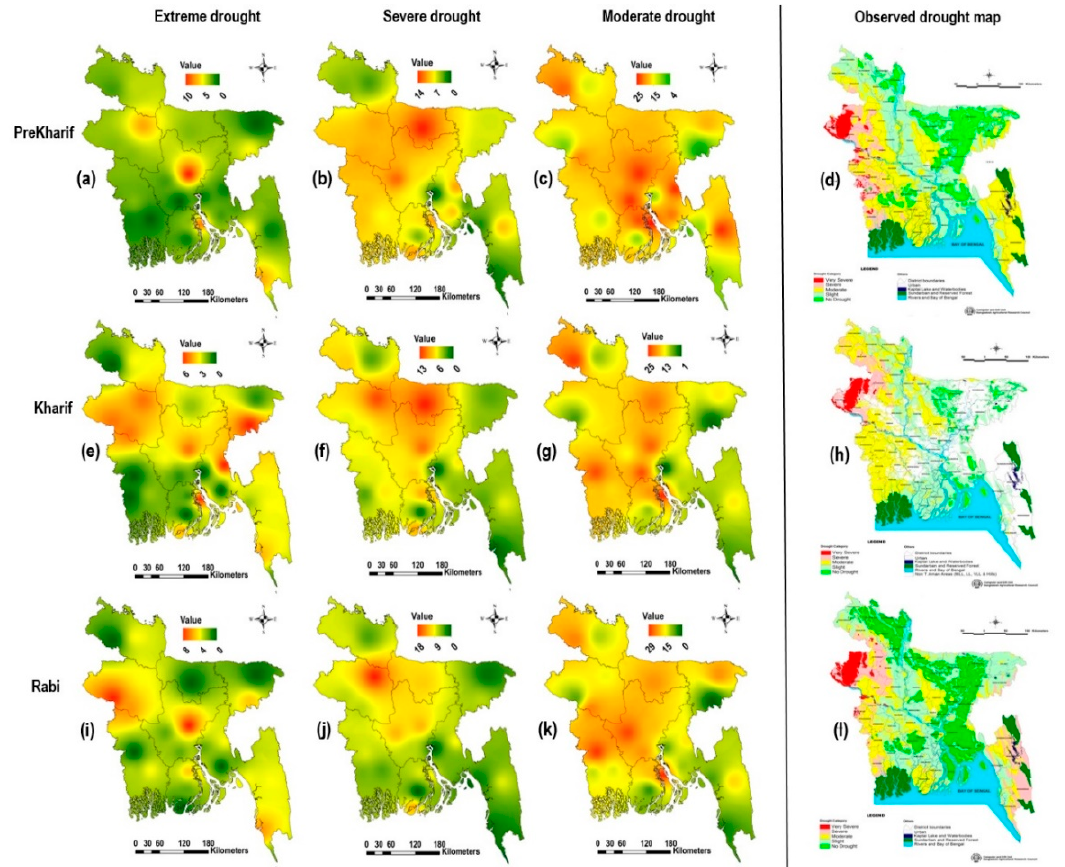
Figure 8. Spatial distribution of seasonal drought in Bangladesh during 1981–2015: Upper row indicates the results for Pre-Kharif season with ( a ) Extreme; ( b ) Severe; ( c ) Moderate Severities, and ( d ) Observed distribution, middle row shows the results for Kharif season with ( e ) Extreme; ( f ) Severe; and ( g ) Moderate Severities and ( h ) Observed distribution and bottom row is for the Rabi season with ( i ) Extreme; ( j ) Severe; ( k ) Moderate severities; and ( l ) Observed distribution. The observed agricultural drought maps (right column) were developed by BARC in 2000 (Source of the observed map: http://maps.barcapps.gov.bd/index.php).